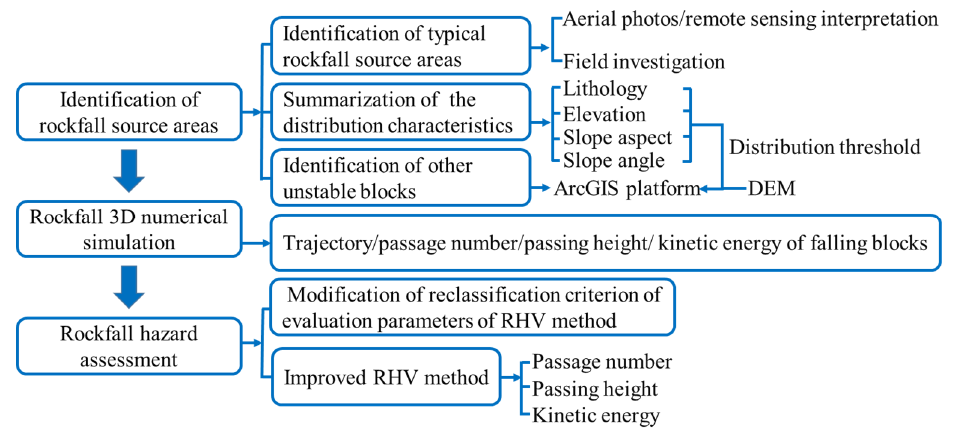
Figure 3. The methodology flow chart of this study.